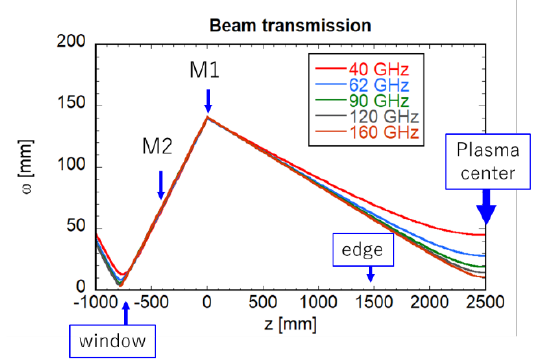
Fig. 3. Beam size evolution at each position, determined by Gaussian beam propagation theory. z = 0 for the position of